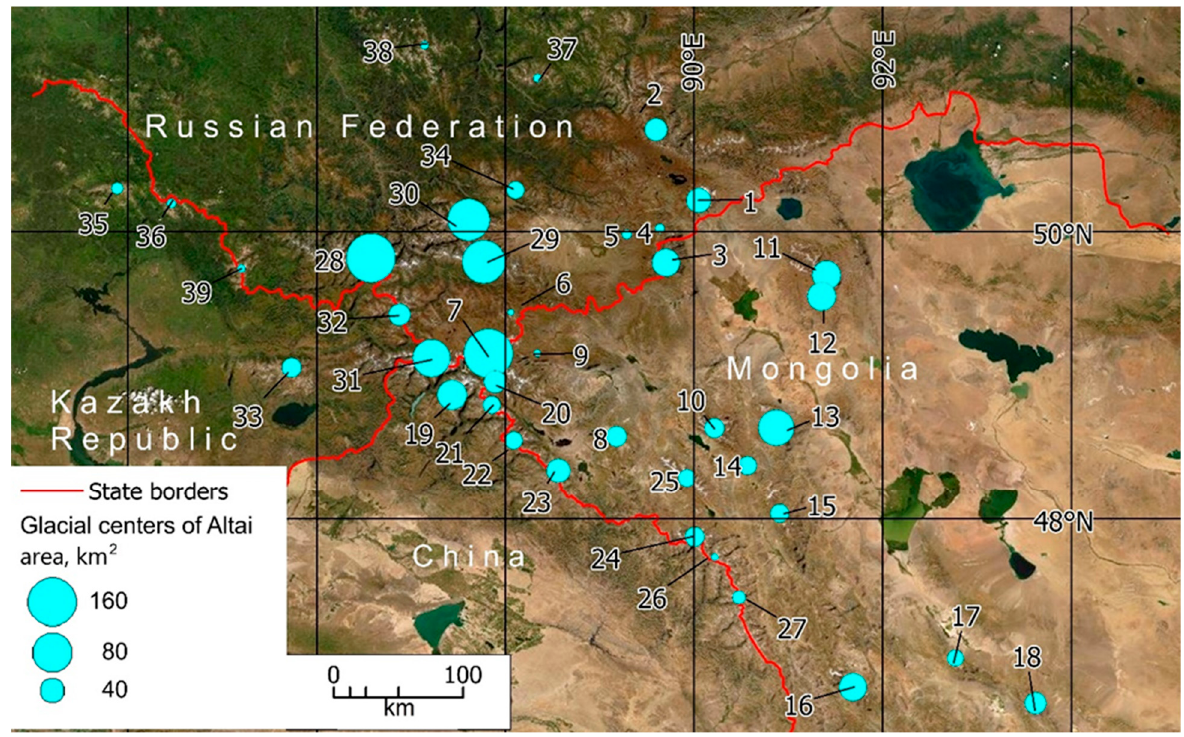
Figure 6. Recent glaciation of Altay mountains. The numbers correspond to the ones in Table 4. According to our reconstruction, in the southern half of the Altai mountainous country, at the maximum of the LIA, there were 2276 glaciers with total area 1348.43 km 2 , the subsequent decrease of the total glacier area makes 59% with average ELA rise of 106 m (Table 5). An example of glacial shrinkage after the LIA maximum is given in Figure 7. For the northern part of Altai, we used the only currently available estimate of the glacier area for the maximum of the LIA, taken from [41,69]. This estimate is very rough and the glacier area in it is underestimated, since the authors reconstructed mainly large glaciers, excluding completely disappeared glaciers and empty cirques. Taking into account these data, we estimate the total area of LIA glaciers of Altai by 2288.04 km 2 , and the